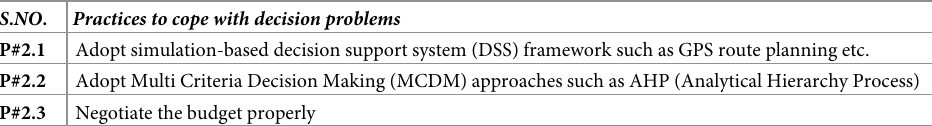
Table 5. Practices to cope with decision problems in COR.